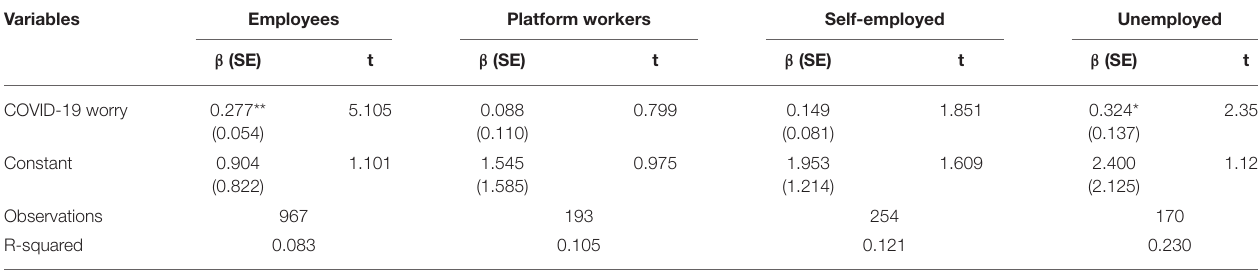
TABLE 6 | Effect of COVID-19 worry on mental health, by employment